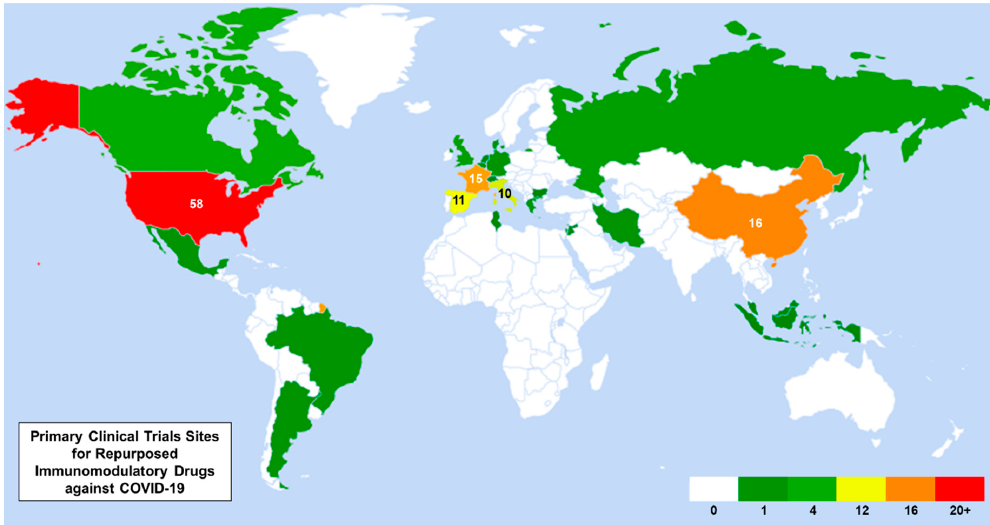
Figure 2. World heat map of the primary clinical trial sites for repurposed immunomodulatory drugs against COVID ‐ 19. The number of clinical trials is labeled within each country, if greater than five trials.